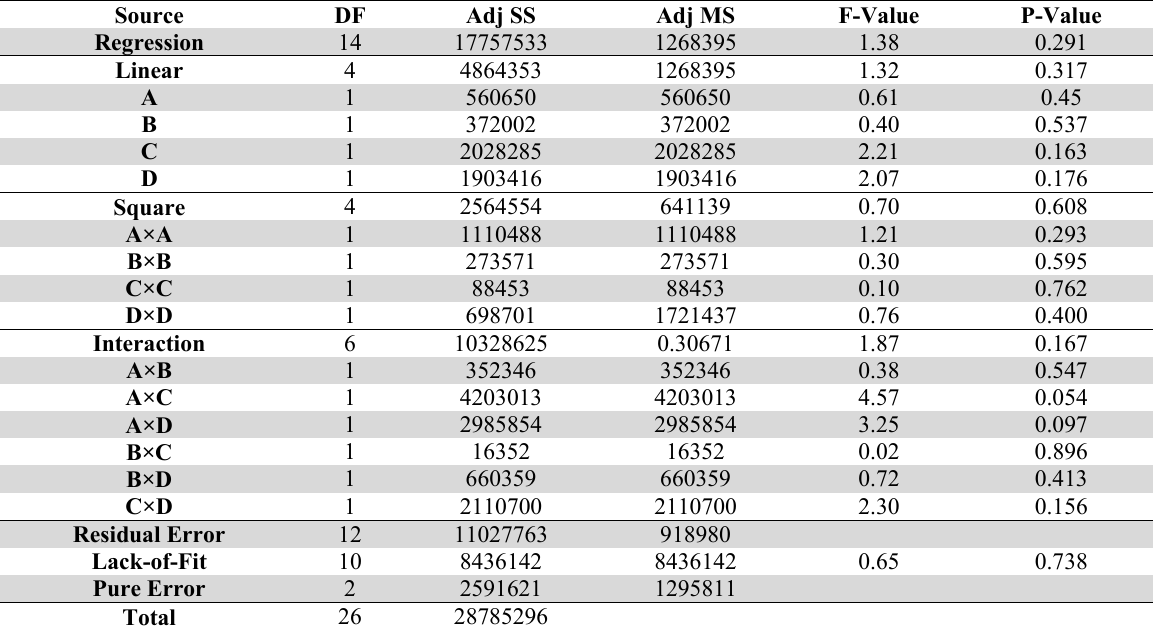
Analysis of Variance of